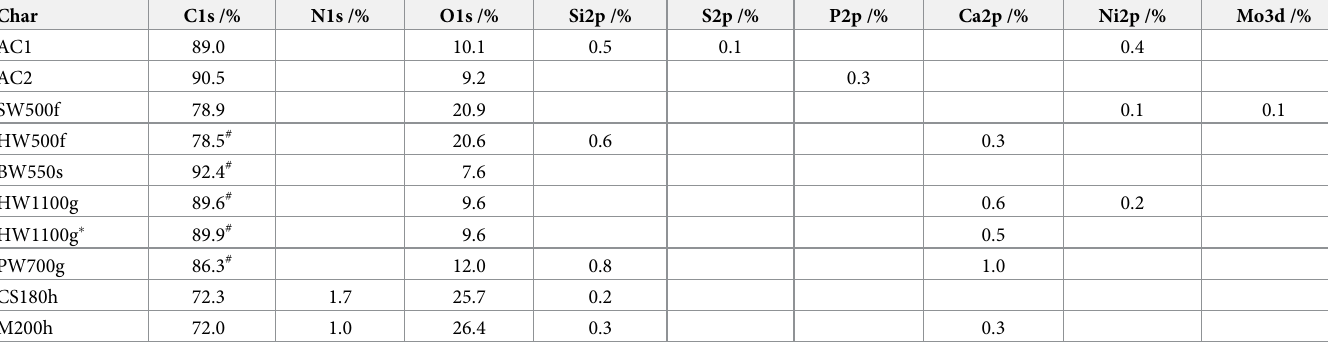
Table 6. XPS survey on different elements at the surface of ground chars and HW1100g � without pretreatment. Char